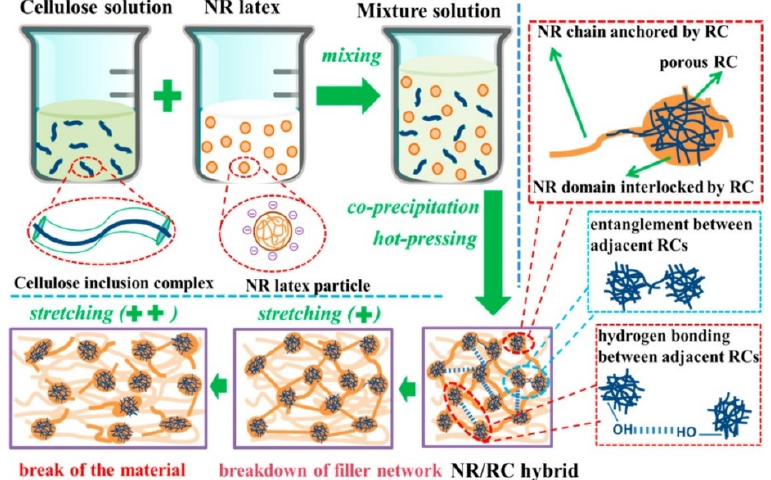
Figure 8. Schematic illustration of NR reinforced with regenerated cellulose in alkaline urea–aqueous system. Reprinted with permission from [123] . Copyright 2017 American Chemical Society.